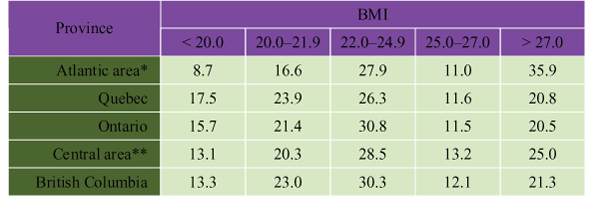
Percentage of Canadian Women from Each Province in Each BMI Category Source: Statistics Canada, NPHS, 1996–1997